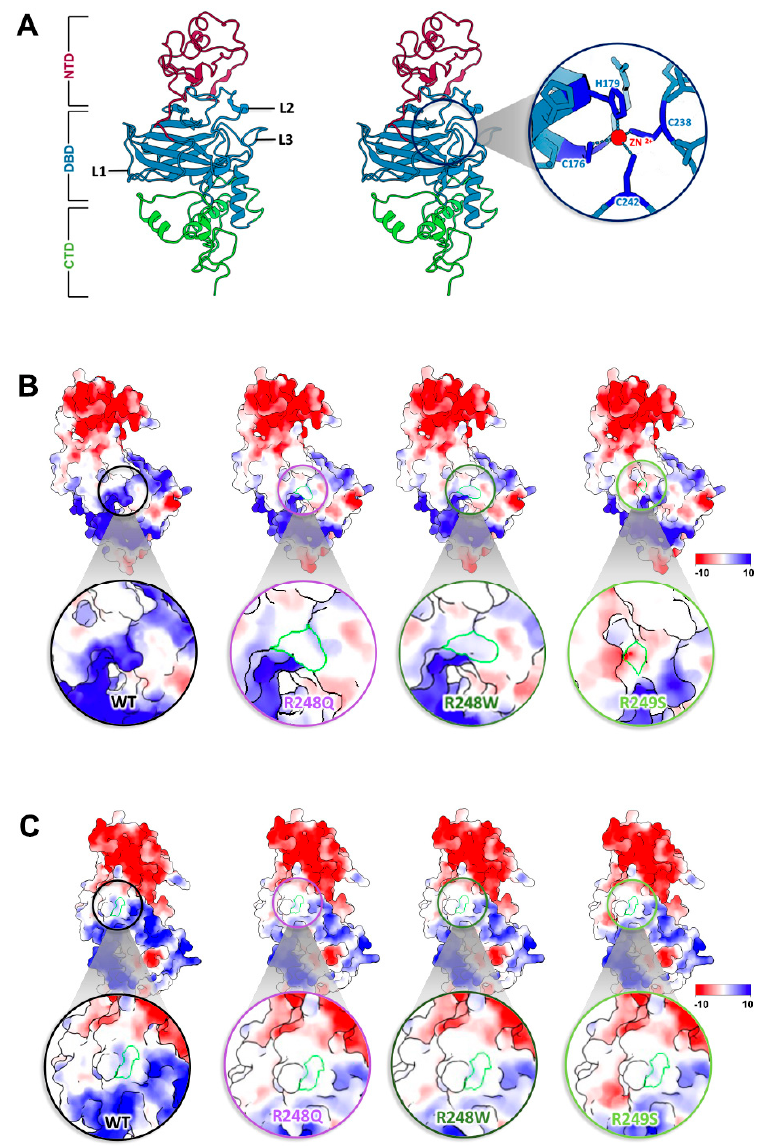
Figure 3. Hotspot mutations alter the electrostatic surface near a key zinc ion coordination site. ( A ) Residues in L1–L3 loop regions of the DBD provide structural integrity within the central part of the p53 protein. A magnified view of the zinc coordination site within the DBD shows key coordinating residues. ( B ) Electrostatic surface potentials mapped for residues R248Q, R248W, and R249S (highlighted with a green border) proximal to the critical zinc ion coordination site. ( C ) Surface charge potentials of an adjacent region show notable changes in point mutations with respect to WT p53. Green border indicates regions of differences. Scale for acidic to basic residues ranges from − 10 (highly negative) to 10 (highly